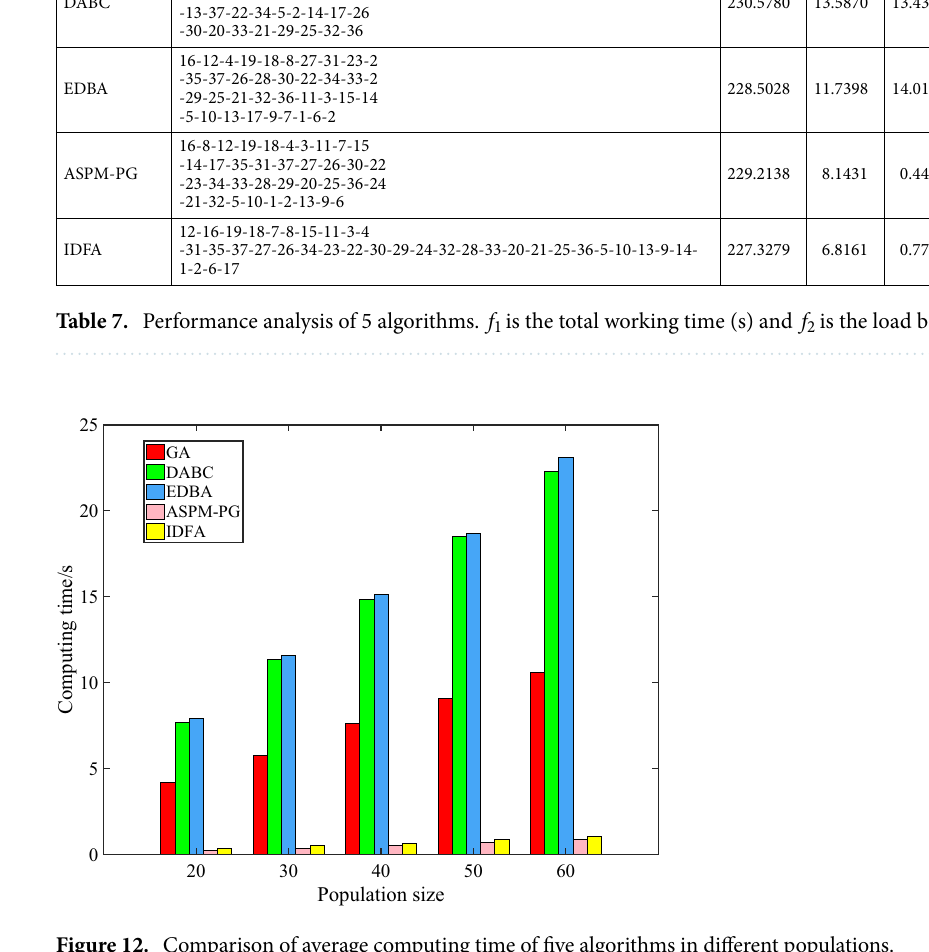
Figure 12. Comparison of average computing time of five algorithms in different